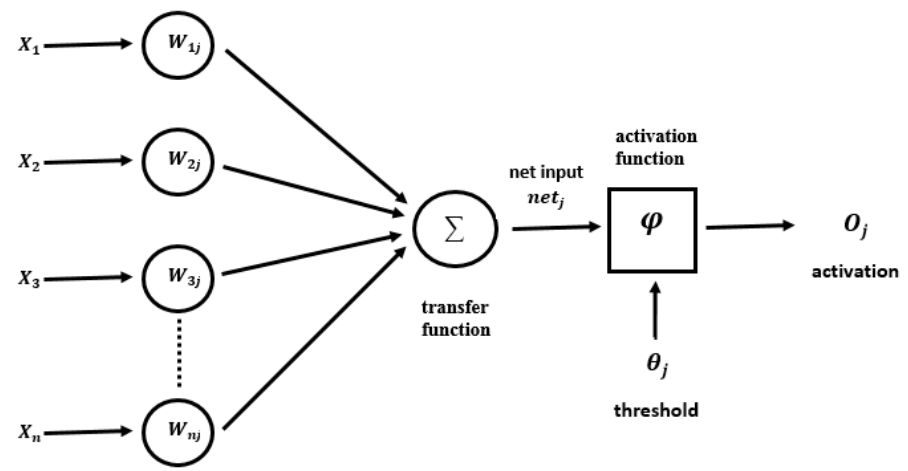
Figure 2. A simple structure of the artificial neuron [30].